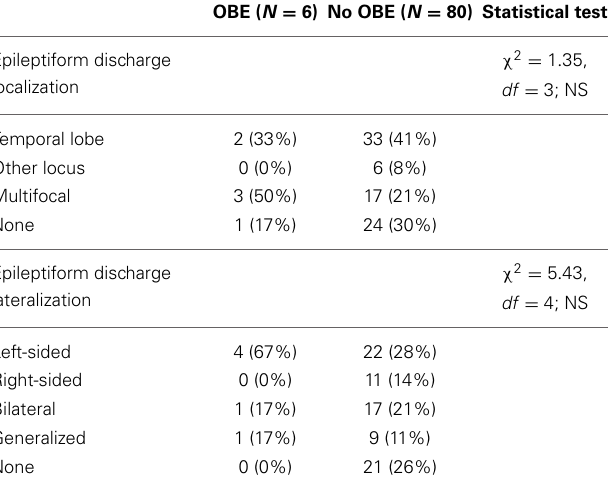
Table 6 | EEG variables among patients with and without out-of-body experiences (OBEs).